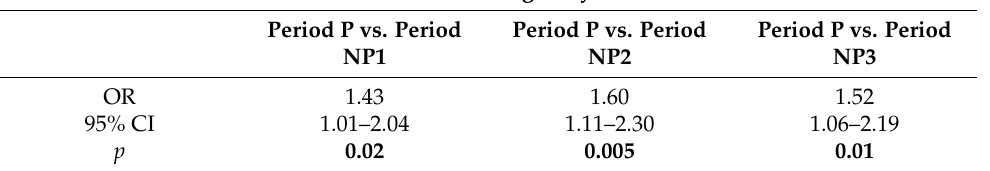
Table 7. The odds of performing only one phenylalanine (Phe) blood test in the assessed time intervals (lockdown period vs. non-lockdown periods) for patients ( n = 266) who completed the Phe test in all four assessed time intervals. Odds of Having Only One Phe Test in a Period Period P vs. Period